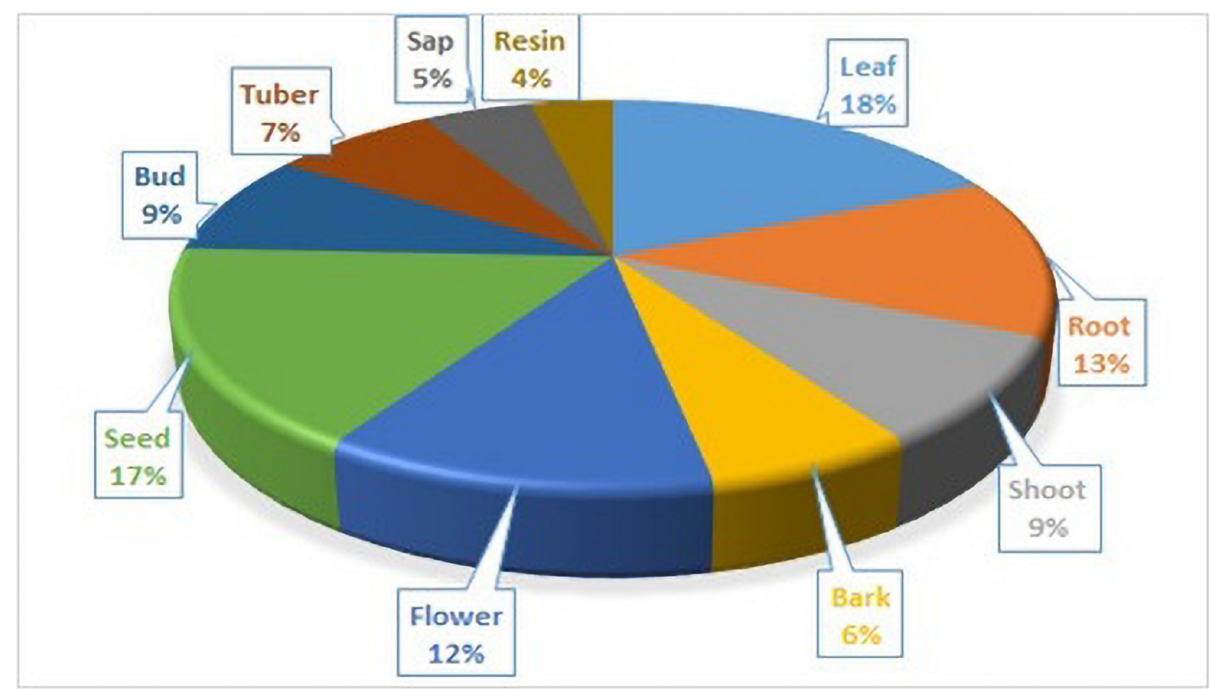
Fig 8. Different parts of plants used for the treatment of different diseases in study area of Dawarian and Rati Gali of District Neelam of Azad Jammu and Kashmir.